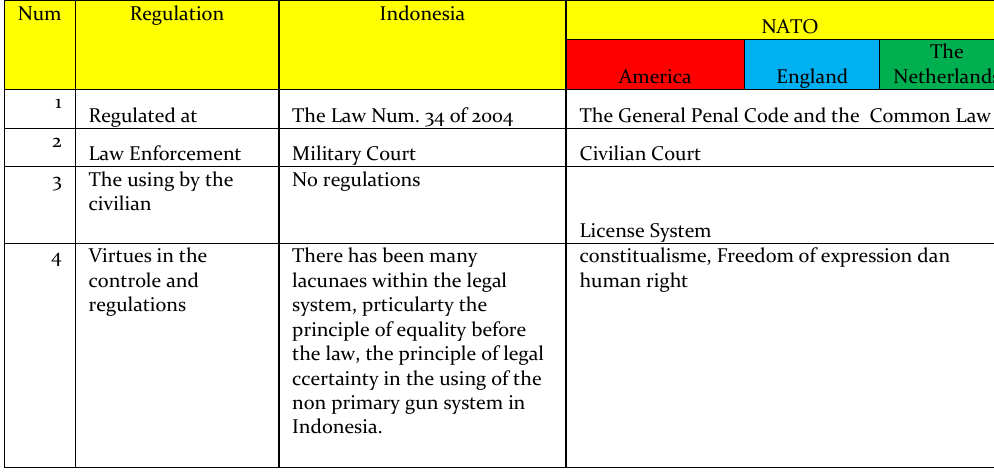
Comparatieve Analysis of the Regulation for the Use of the Non-Primary Gun System in Indonesia and Other